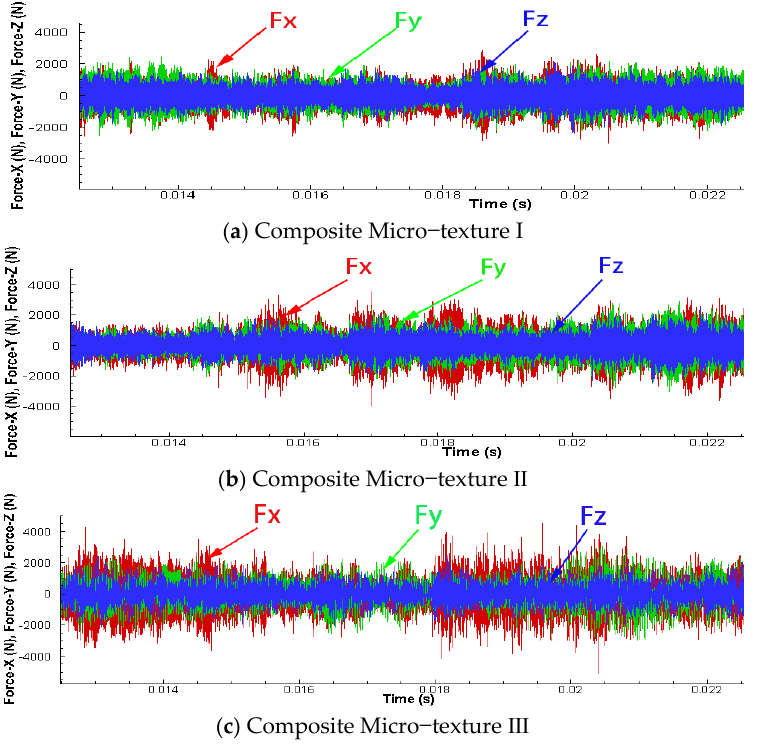
Figure 10. Mechanical wave diagram of cutting force of three kinds of composite micro−texture tools.